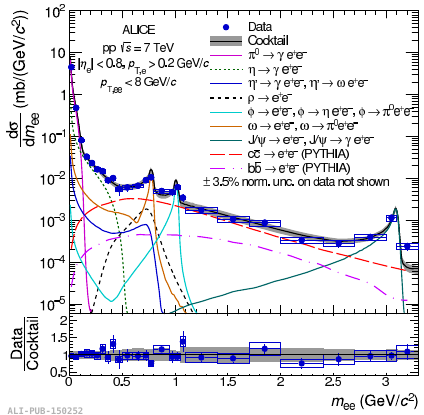
Figure 1. Dielectron cross section as a function of m ee compared to a cocktail of known hadronic